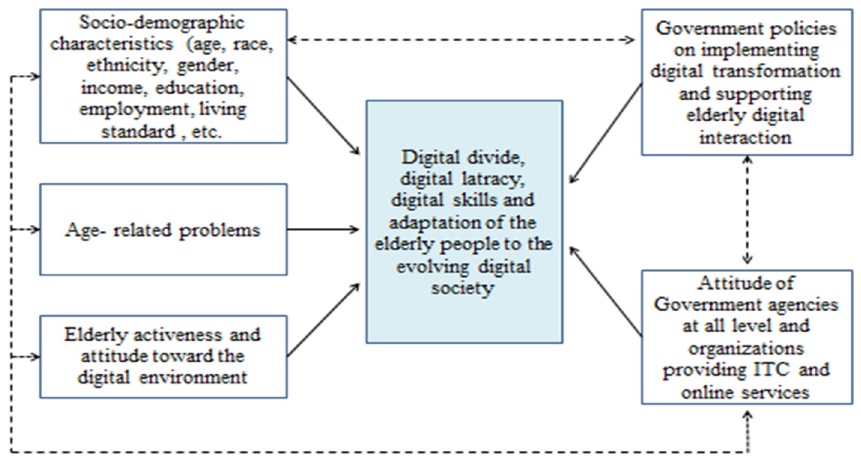
Figure 1. Sample diagram factors affecting the digital interactions of the Vietnamese elderly.